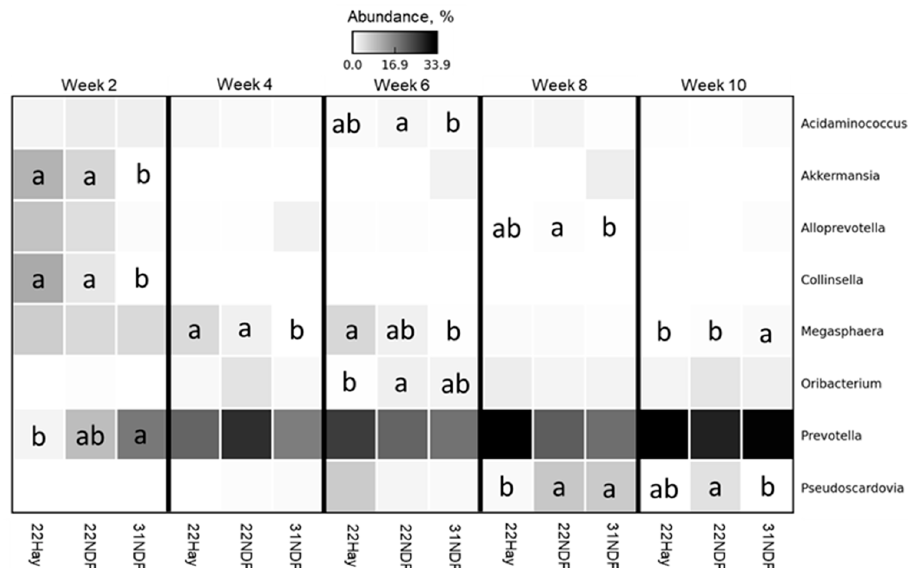
Figure 3. Differential abundance in most abundant bacterial genera in ruminal fluid samples of dairy calves fed different levels and sources of NDF. Data are visualized as heatmap. Comparisons are among treatments within week. Means followed by the same letter are not significantly different by the t -test ( p > 0.05). Genera rows without letters were not significantly different; 22NDF—calves fed starter concentrate with 220 g NDF/kg; 22Hay—calves fed starter concentrate with 220 g NDF/kg and grass hay; 31NDF—calves fed starter concentrate containing 310 g NDF/kg.